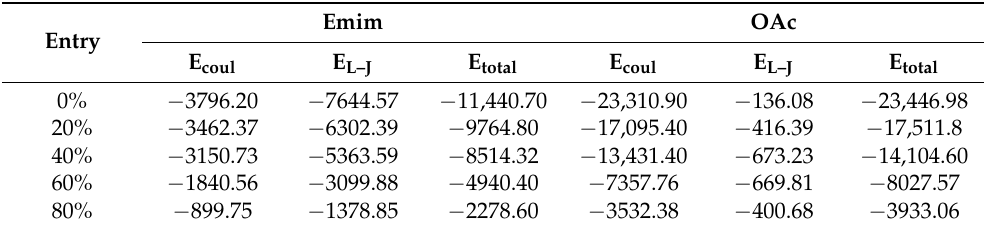
Table 1. Interaction energies (kJ/mol) between cellulose chains and anion/cation of EmimOAc in different water